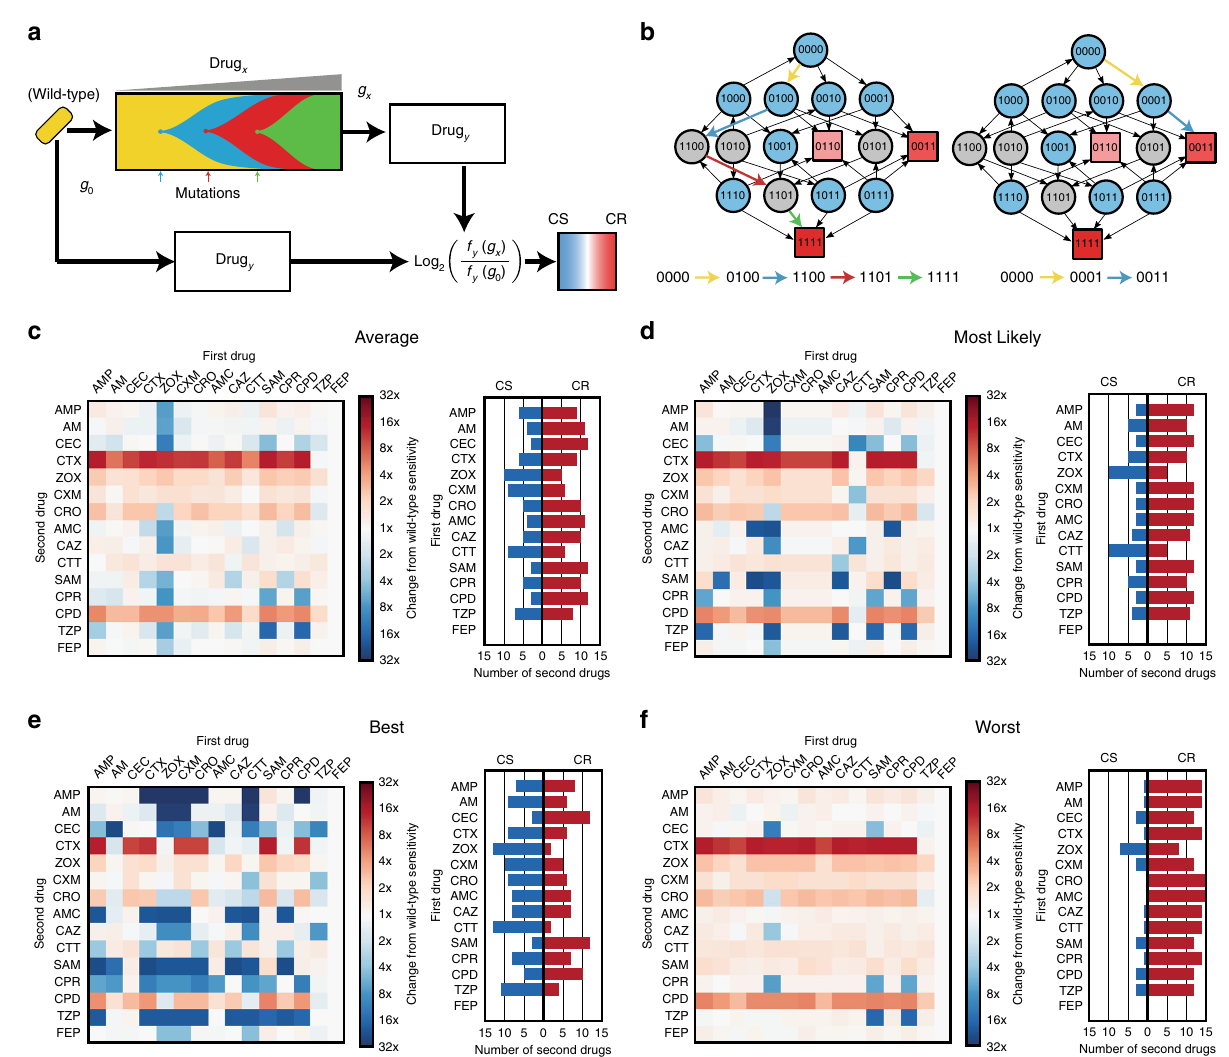
Fig. 2 Mathematical modelling predicts highly variable collateral response. a A schematic of the model used to derive collateral response. Sequential mutations are simulated to fi x in the population until a local optimum genotype arises. The fi tness of this resultant genotype is compared to the fi tness of the wild-type genotype for each of the panel of antibiotics. b The landscape for ampicillin derived by Mira et al. 29 represented as a graph of genotypes. Arrows indicate fi tness conferring mutations between genotypes represented as nodes. Blue nodes indicate genotypes from which evolution can stochastically diverge, grey nodes indicate genotypes from which there is only a single fi tness conferring mutation. Squares indicate local optima of fi tness with colour indicating the ordering of fi tness amongst these optima (darker red indicates higher fi tness). Two divergent evolutionary trajectories, in the sense of the model shown schematically in ( a ), are highlighted by coloured arrows. c – f The average, most likely, best case, and worst case tables of collateral response derived through stochastic simulation. Columns indicate the drug landscape under which the simulation was performed and rows indicate the follow-up drug under which the fold-change from wild-type susceptibility is calculated. Bar charts indicate, for each labelled fi rst drug, the number of follow-up drugs exhibiting collateral sensitivity (blue) or cross-resistance (red) in each case. CS - collaterally sensitive, CR - cross